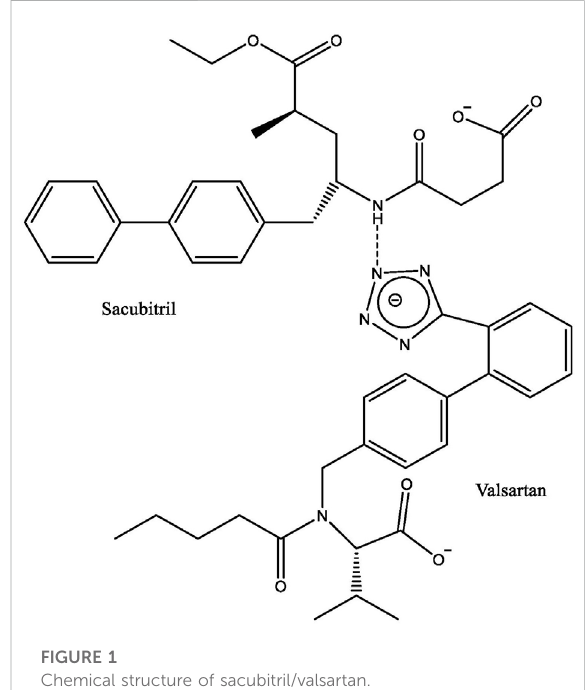
Chemical structure of